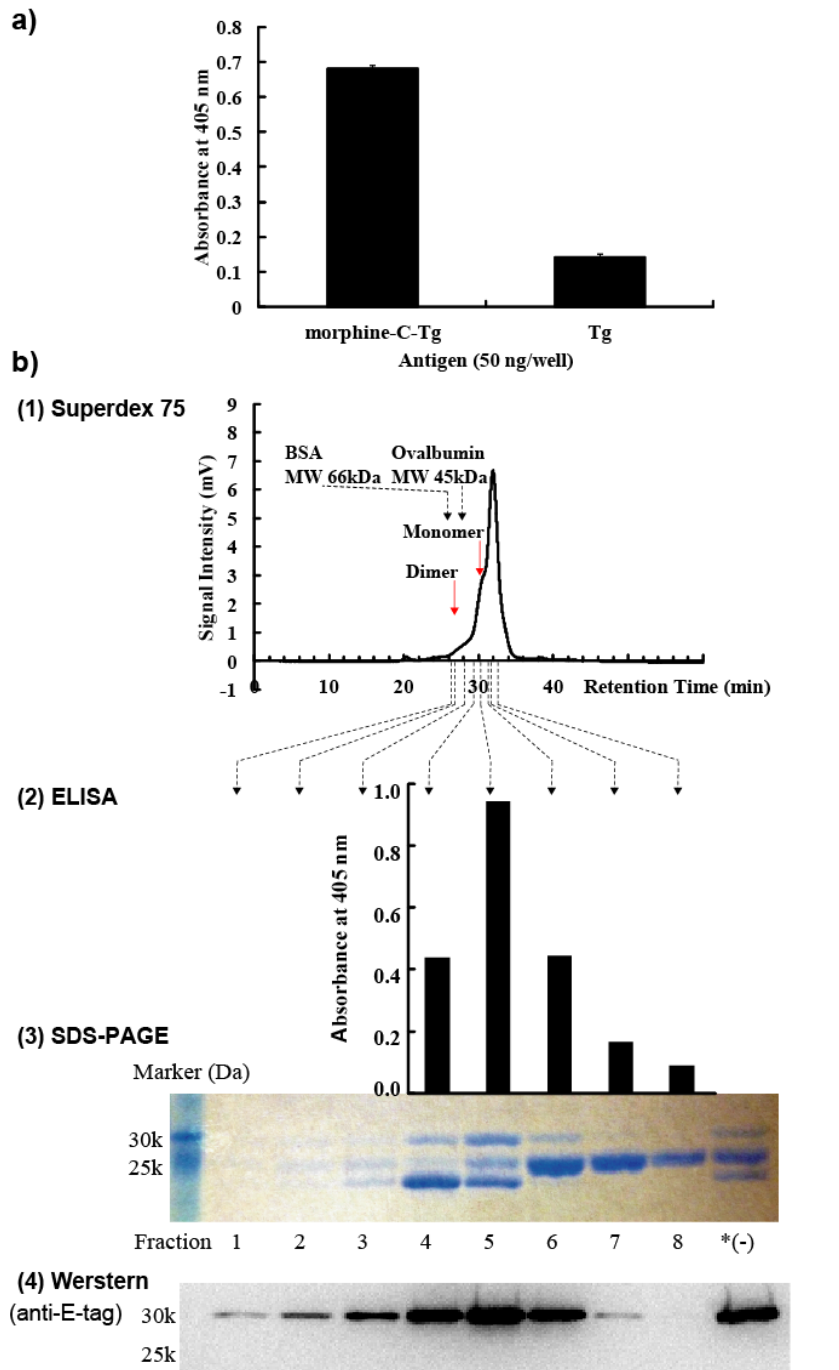
Figure 2. Biochemical characterization of M86. ( a ) Phage clone M86 bound to morphine- C-Tg. ( b ) (1) Size-exclusion HPLC chromatography. Red arrows indicate the positions of the dimer or monomer form of M86. (2) ELISA analysis (upper panel). (3) SDS-PAGE analysis (middle panel). *( − ): HisTrap HP column-purified M86. (4) Western blotting analysis (lower